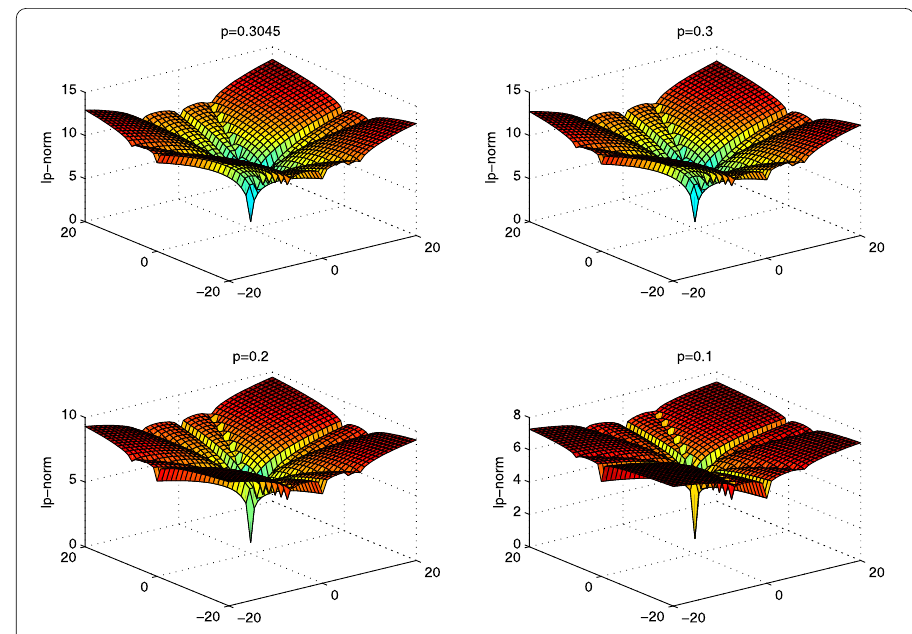
Figure 2 The p -norm of the solutions of the different cases in Example 2.